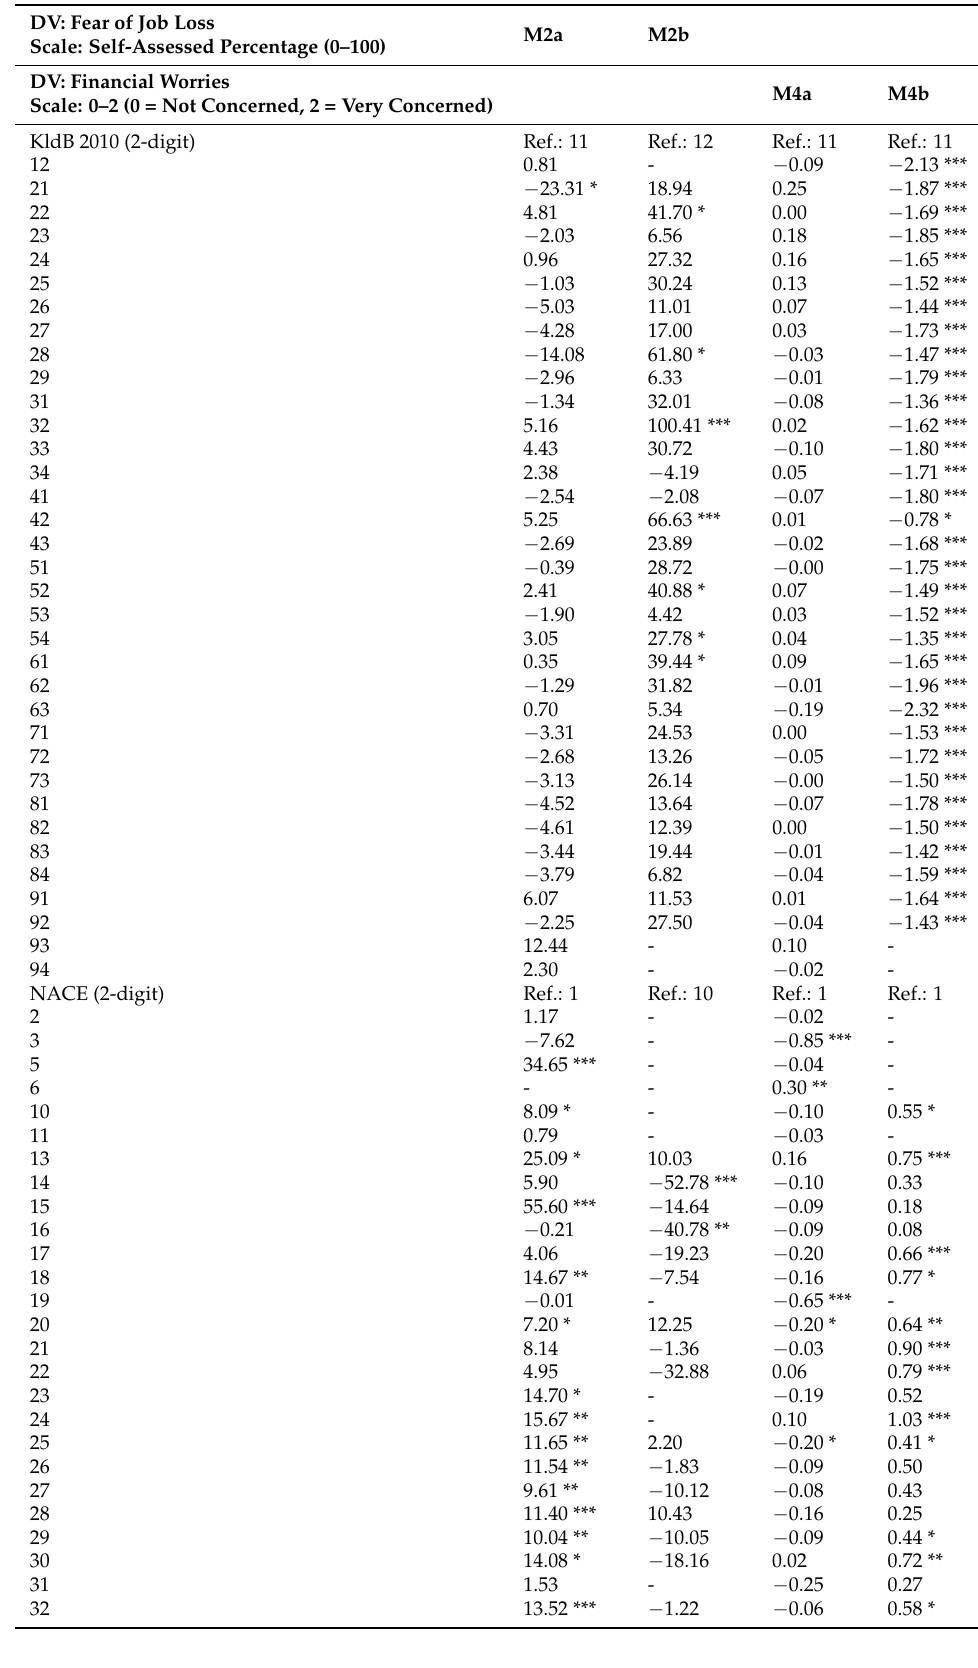
Table A5. Linear regressions, estimates for occupation and industry fixed